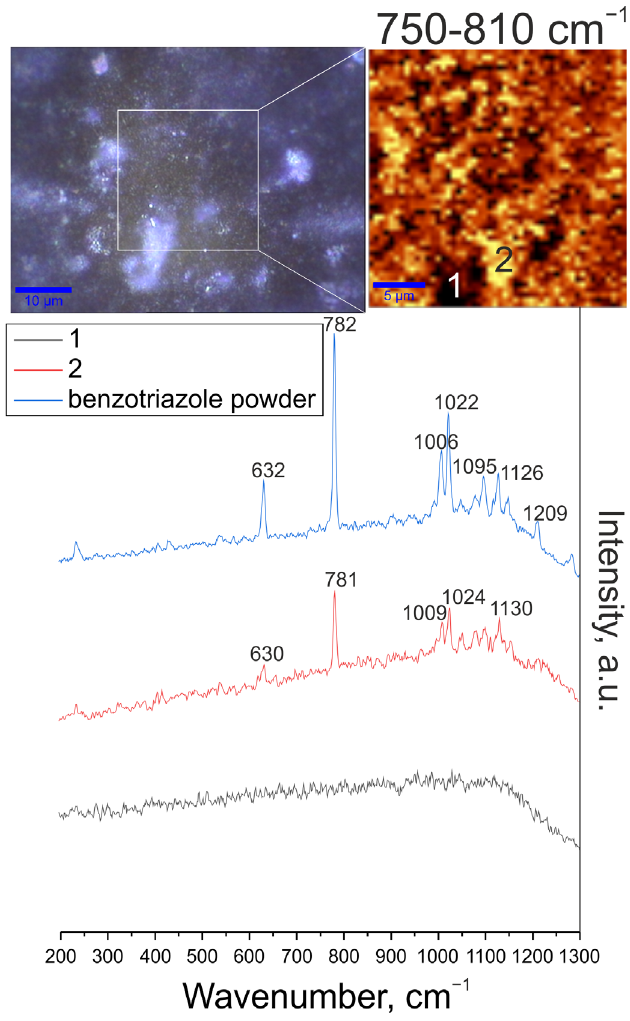
Figure 6. Image of the studied region in the sample, map of the benzotriazole distribution (2D map was designed using a filter in the spectral range of 750 – 850 cm −1 corresponding to the characteristic peak for benzotriazole), Raman spectrum of benzotriazole powder and Raman spectra of surface areas corresponding to areas of high and low content of the inhibitor.